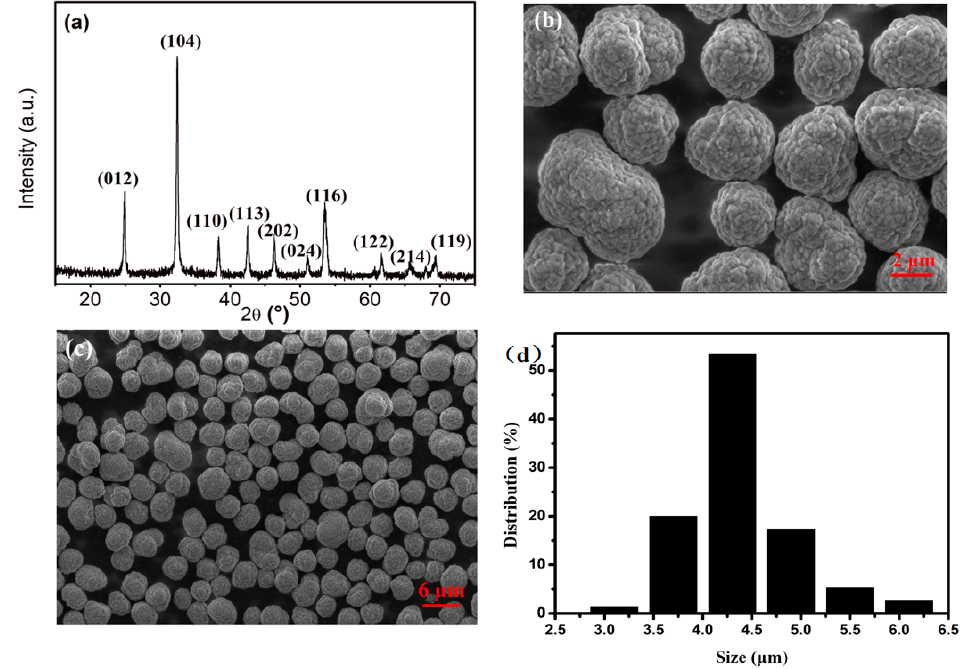
Figure 4. ( a ) XRD scan of the prepared CoCO 3 , ( b , c ) SEM images of the prepared CoCO 3 , and ( d ) particle size distribution of the prepared CoCO 3 .